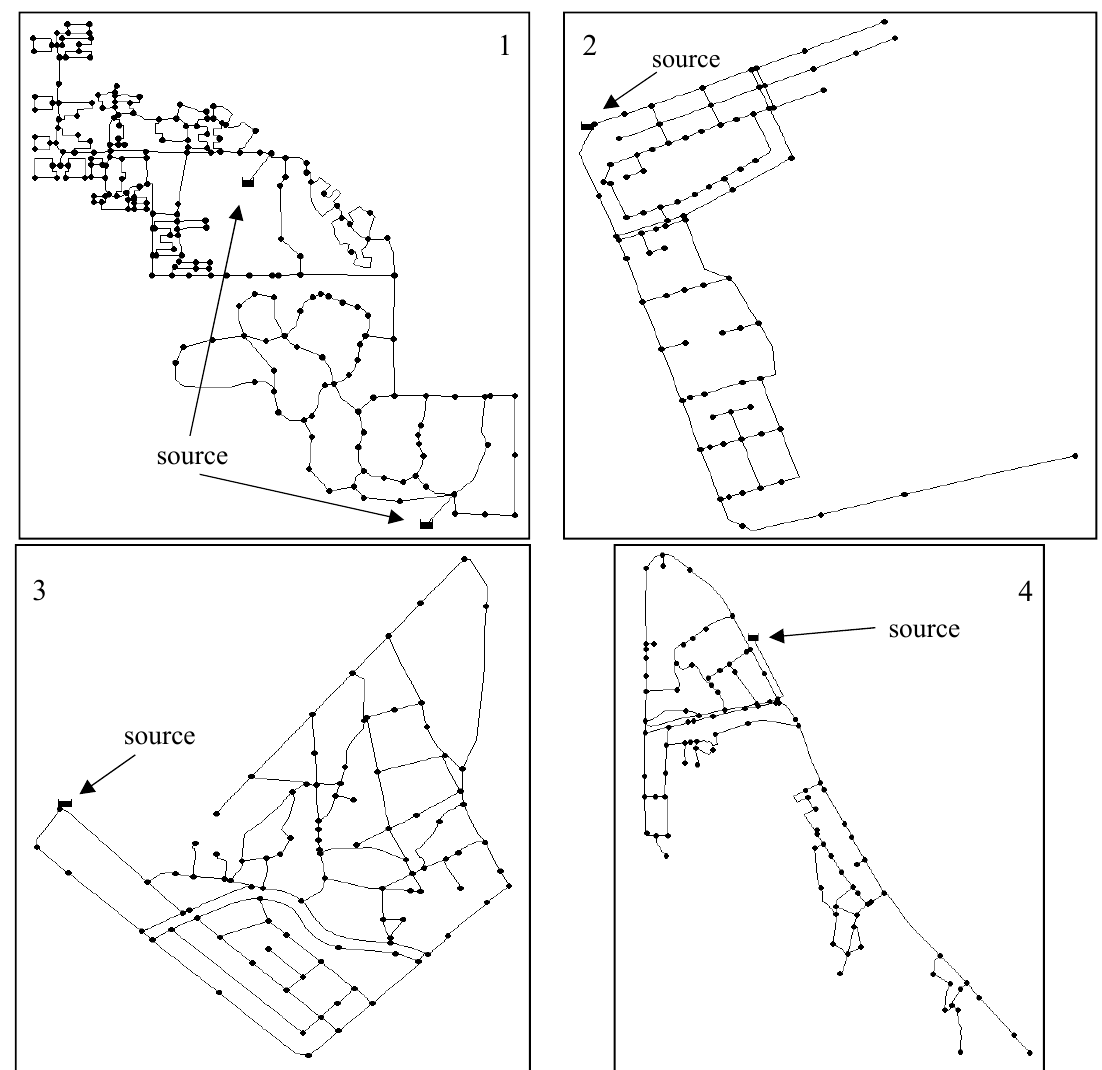
Figure 2. Layout of the networks.